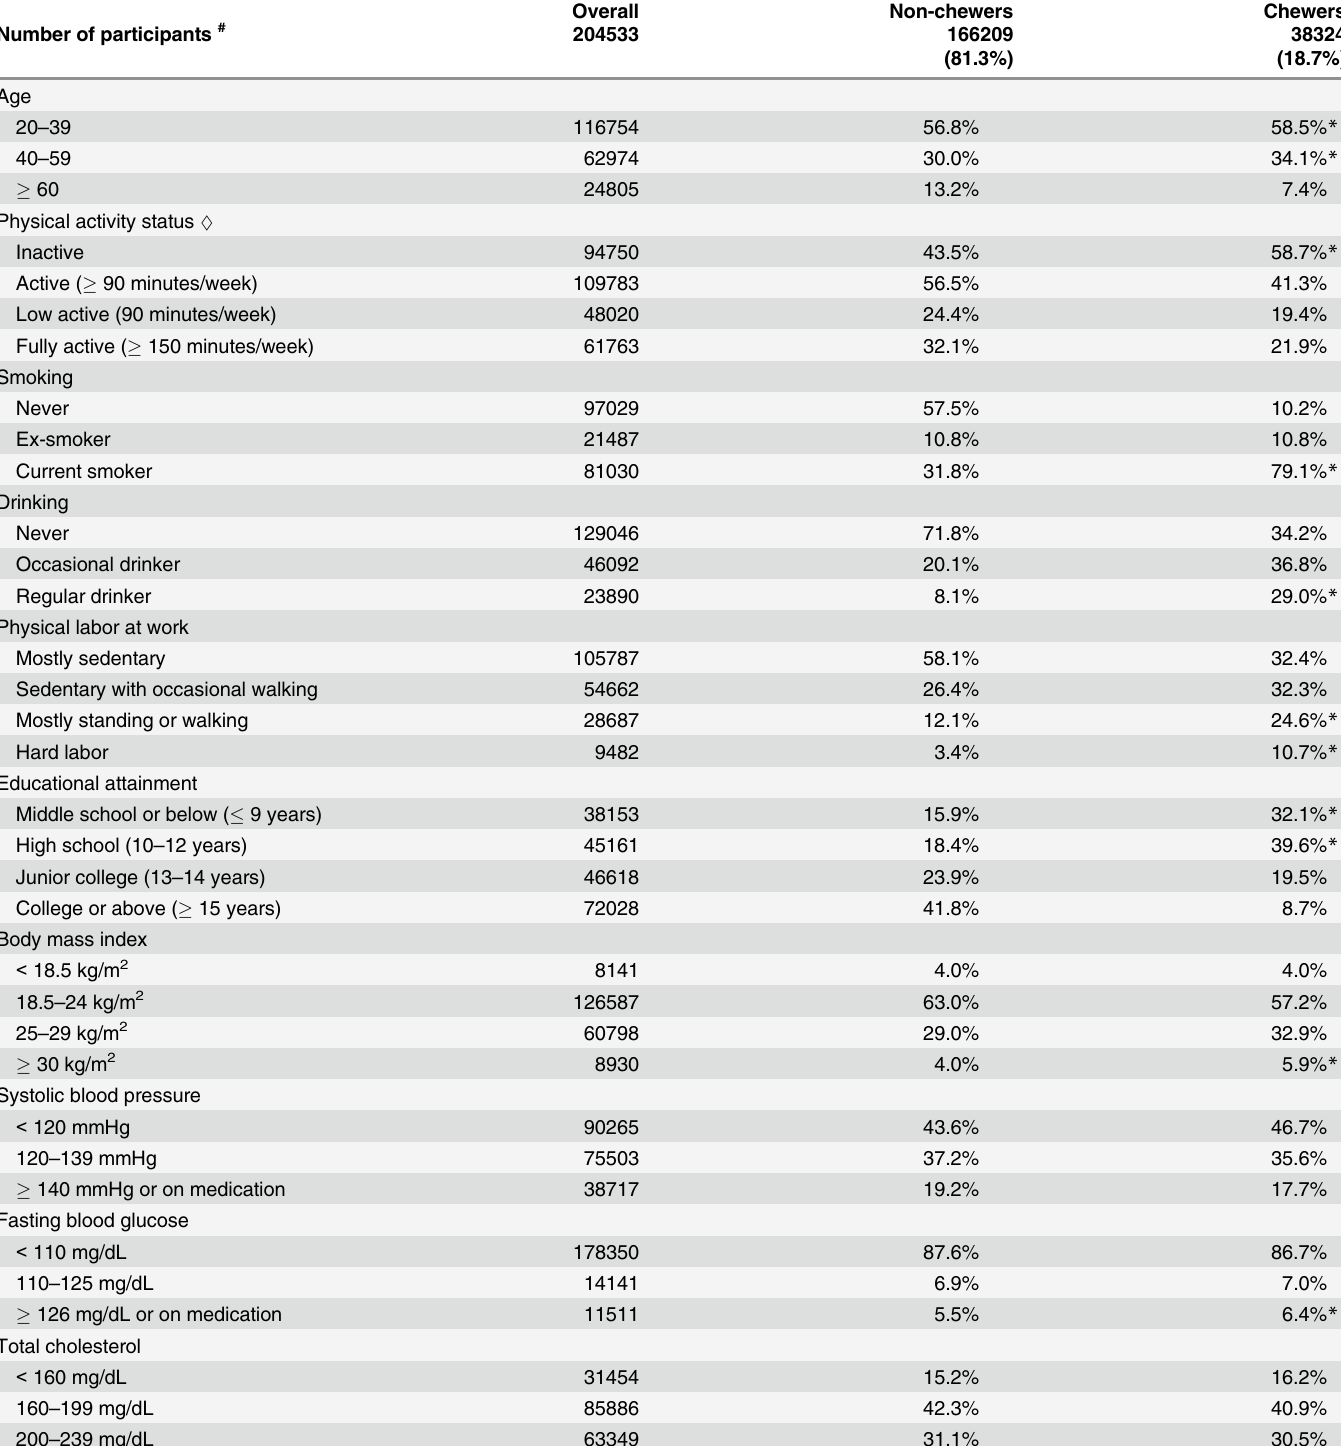
Table 1. Demographics and clinical characteristics by chewing